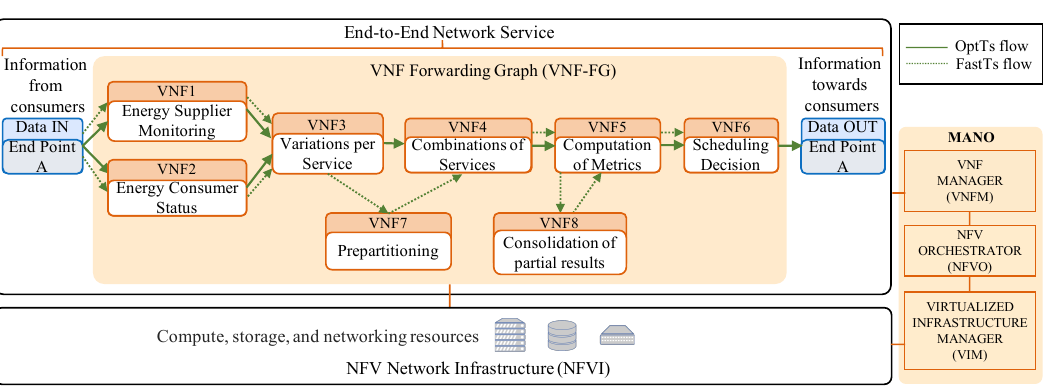
Figure 11. Example of the deployment of O PT T S and F AST T S strategies as SFCs in the NFV-enabled Energy Manager